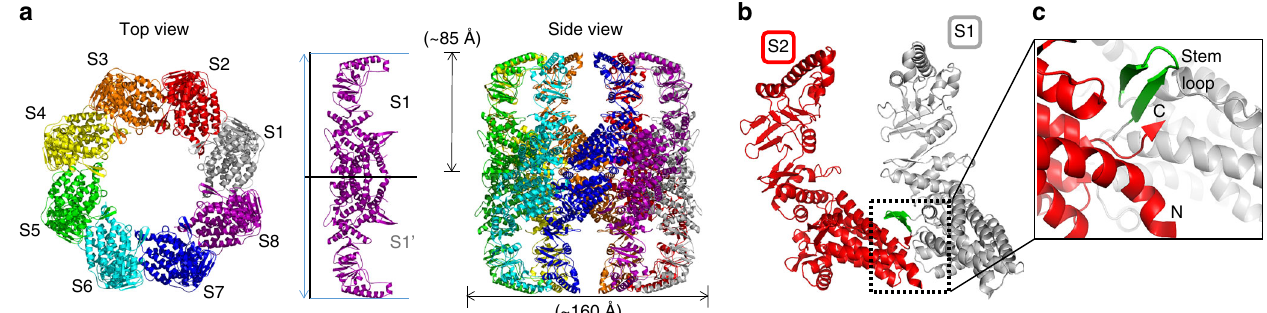
Fig. 3 Crystal structure of Ch-CPN in the open state. a Overall structure of the ADP-bound Ch-CPN. Subunits are labeled as S1 – S8 and shown in different colors. The conformation of an inter ring dimer (S1 and S1 ′ ) is depicted to calculate the molecular dimension (middle). b A contact area in the intra ring dimer is indicated by a dotted box. c Close-up view of the intra ring